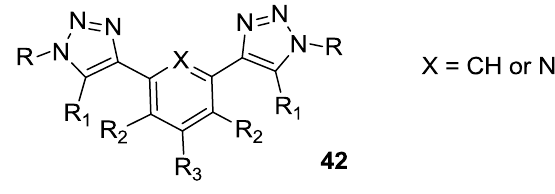
Figure 32. Triazolate ligand studied by Schulze et al. [140,141].